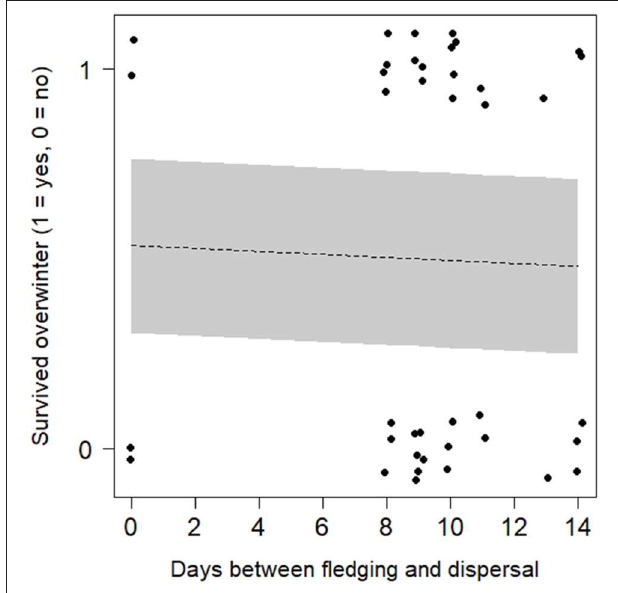
FIGURE 3 | Likelihood of surviving to the following breeding season for fledglings of N = 12 experiment nests, depending on how quickly they dispersed from the natal territory. Points are jittered (by 0.8 on x-axis, 0.5 on y-axis) to improve visibility. Line of best fit (dotted line) and 95% confidence intervals (grey polygon) are calculated from a binomial GLMM exploring variation in survival depending on dispersal timing ( Supplementary Table 3